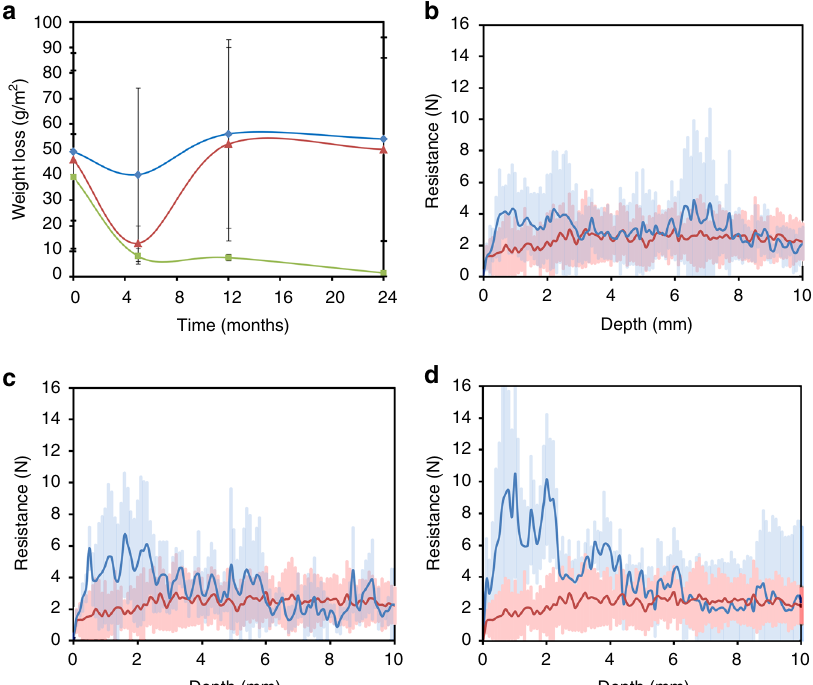
Fig. 5 Consolidation effect of the in situ bacterial bio-treatments. a Peeling tape test (legend: Mx -treatment, blue line and diamond symbols; M-3P treatment, red line and triangle symbols; Bacterial community self-inoculation bio-treatment, green line and square symbols). Error bars show s.d. ( ± 1 σ ). Drilling resistance (DR) along a 1 cm depth pro fi le following Mx -treatment ( b ) (average of at least six measurements per treatment; blue line ), M-3P treatment ( c ) (average of at least six measurements per treatment; blue line ), and bacterial community self-inoculation bio-treatment ( d ) (average of at least 6 measurements per treatment; blue line ). In b – d the DR of untreated weathered calcarenite stone (average of 14 measurements; red line ) is presented for comparison. Shaded areas in DR graphs show s.d. ( ± 1 σ